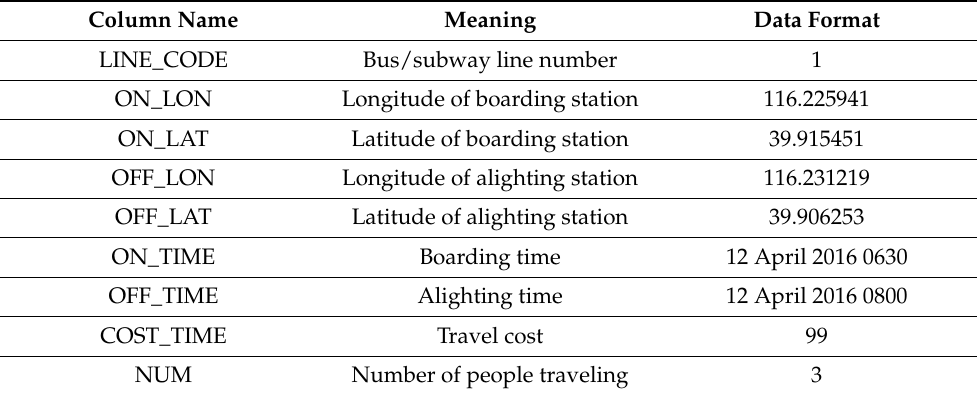
Table 1. Smart card data format.